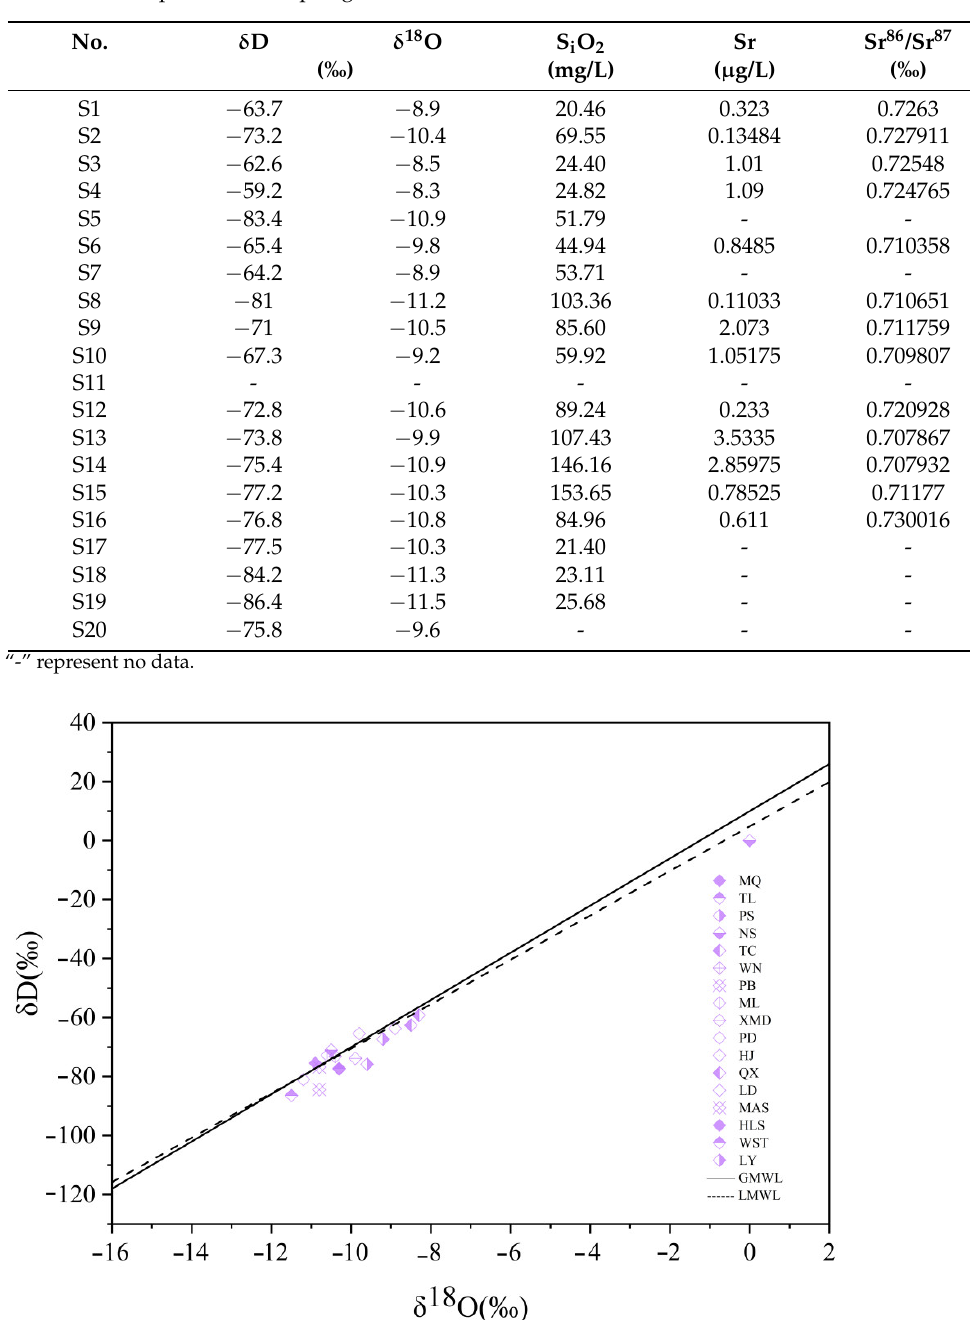
Table 2. The data of Hydrogen and oxygen isotope compositions, silicon dioxide, strontium, and strontium isotopes from hot springs.